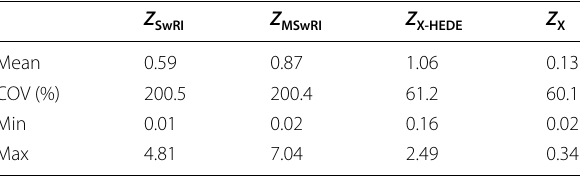
Table 5 Mean and COV of observed-to-predicted ratios for the growth